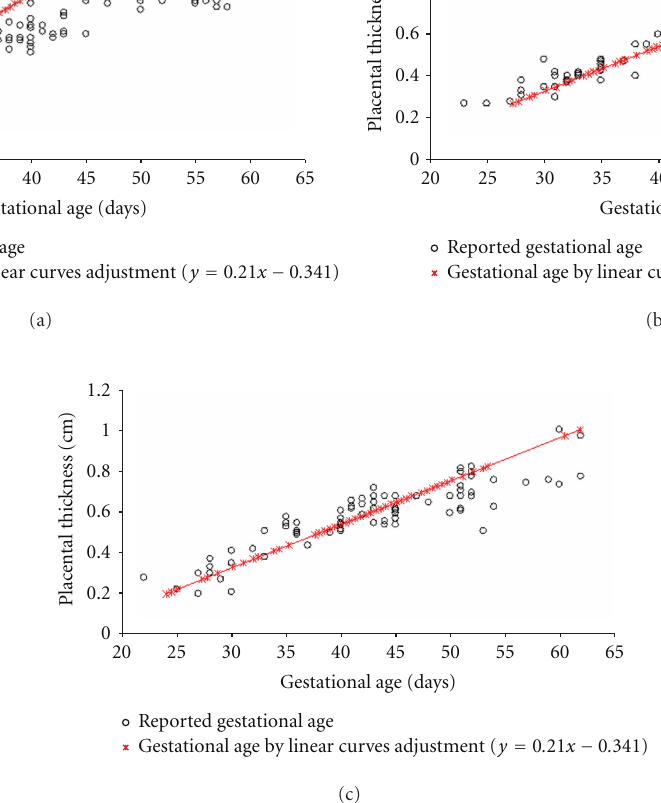
Figure 2: Scatter plot of the relationship of gestational age reported by owners and the one calculated by the linear expression y = 0 . 021 x − 0 . 314 to small (a), medium (b), and large (c) size breed.